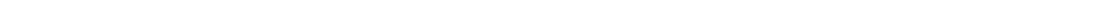
Fig. 5 Deletion of the cytoplasmic domain of IL-13R α 2 resulted in a loss of physical interaction with EGFRvIII and enhanced proliferation is abolished. a Whole-cell lysates prepared from stable cell line Gli36.IL-13R α 2/EGFRvIII cells were used for immunoprecipitation with anti-IL-13R α 2 antibody, then immunoprobed with an anti-EGFR antibody. IgG served as control while unprecipitated extracts serve as input. b Similar cell lysates were reverse immunoprecipitated with anti-EGFR antibody, then immunoprobed with an anti-IL13R α 2antibody. Lysates from Gli36.EGFRvIII served as additional control c Gli36.IL-13R α 2/EGFRvIII cell lysates were immunoprecipitated with anti-EGFR antibody, then immunoprobed with anti-Grb antibody. To further examine the domains of interaction, IL-13R α 2 and EGFR mutants were used. Gli36.EGFRvIII cells were fi rst transfected with pIRESneo2 (Vector), IL-13R α 2 full length (Wild-type) and IL-13R α 2 Cyt tail deleted constructs (Mutant) and then analyzed by d cell proliferation assay at the indicated time points, f co-immunoprecipitation, and h PLA assays. Findings were validated using Gli36.IL-13R α 2 cells transiently transfected with vector (CTRL), full length/wild- type EGFRvIII, DK, and DY3 mutants. e proliferation outputs, g co-immunoprecipitation, i and PLA assay were performed. j represent the corresponding positive and negative